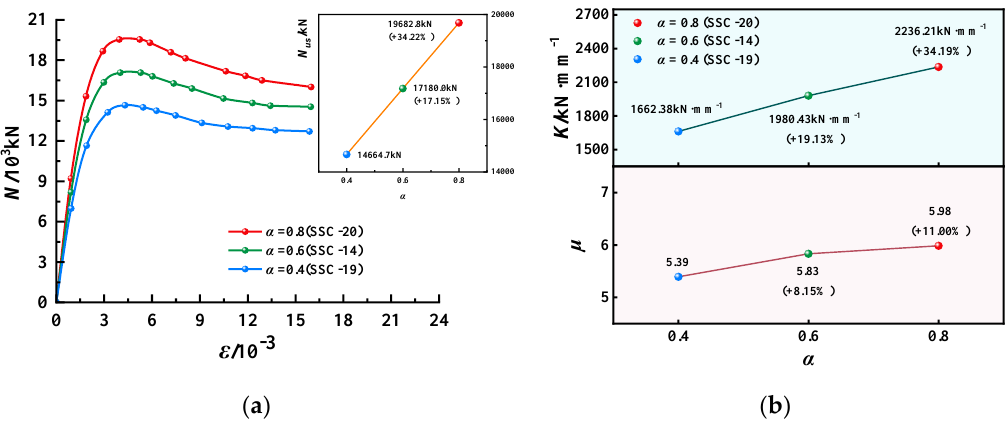
Figure 17. N - ε curves, K and µ of EGCSSCs with different α : ( a ) N - ε curves of specimens with cross-section height of 800 mm. ( b ) K and µ of specimens with cross-section height of 800 mm.